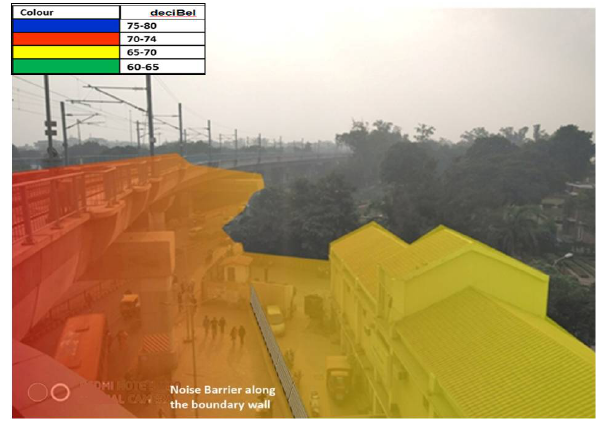
Figure 11: 3D noise mapping of Jamia Millia Islamia (Maktba) after installation of noise